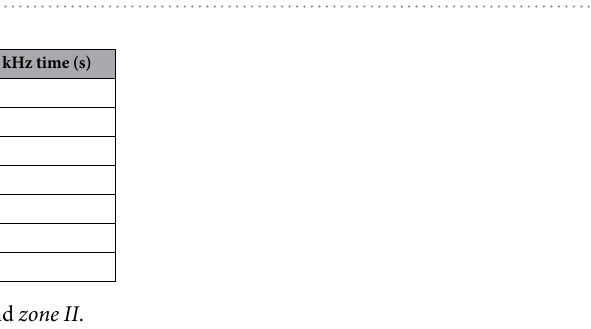
Figure 5. Slopes of ozone production curves corresponding to different values of t eff . ( a ) Voltage/frequency: 7 kVpp/10 kHz. ( b ) Voltage/frequency: 8.5 kVpp/14 kHz.